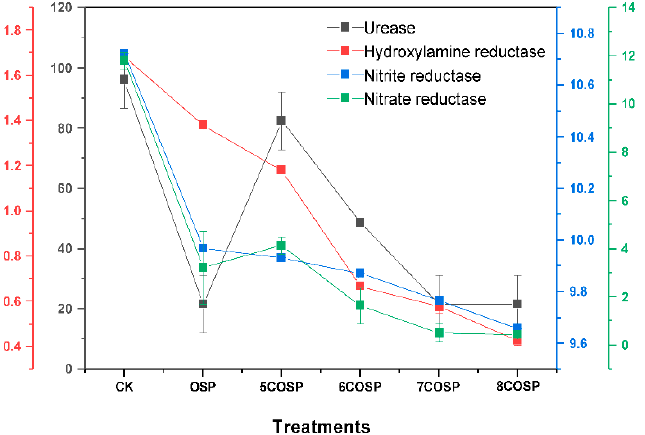
Figure 6. Enzyme activities of soils cultured with the treatments. CK: Urea treatment had a N appli- cation level of 200 mg/kg; OSP: 0.2 wt.% OSP; 5–8COSP: 0.2 wt.% OSP calcined at various temperatures; particle size of the OSP and four COSPs = 0.15 mm; the unit for soil urease, nitrate reductase, and nitrite reductase is mg·g − 1 ·24 h − 1 ; the unit for hydroxylamine reductase is mg·g − 1 ·5 h − 1 . Compared to OSP treatment, the application of 5COSP significantly increased soil urease and nitrate reductase activities by 2.81 and 1.29 times, respectively. However, after 8COSP treatment, the activities of nitrate reductase, nitrite reductase, and hydroxylamine reductase decreased by 86.60%, 3.12%, and 68.88%, respectively. Overall, the activities of